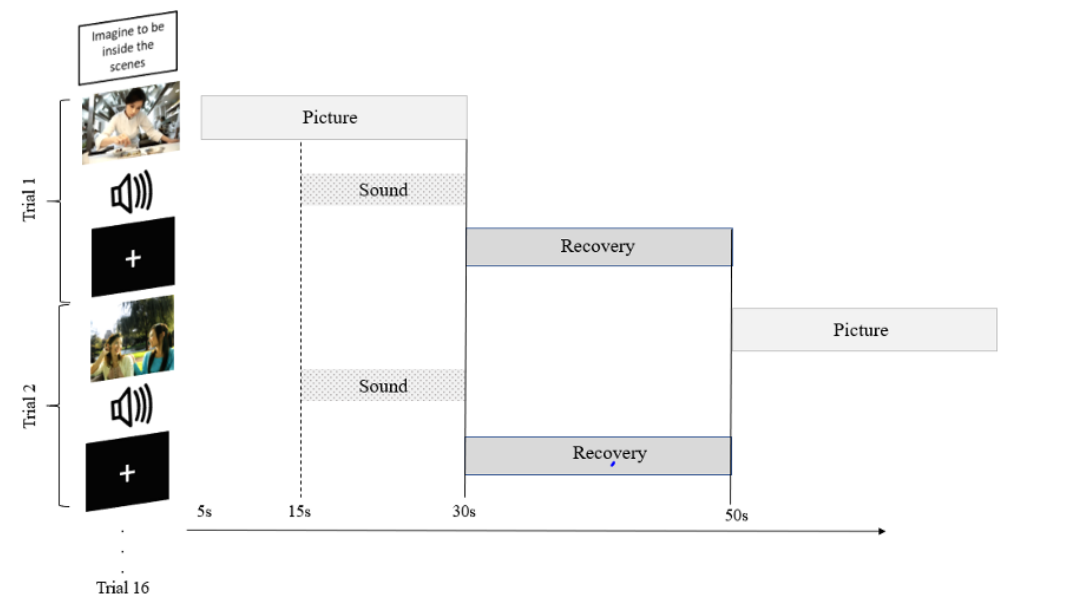
Figure 2. Experimental design. Schematic diagram illustrating onset and offset of picture and sound pairings for each